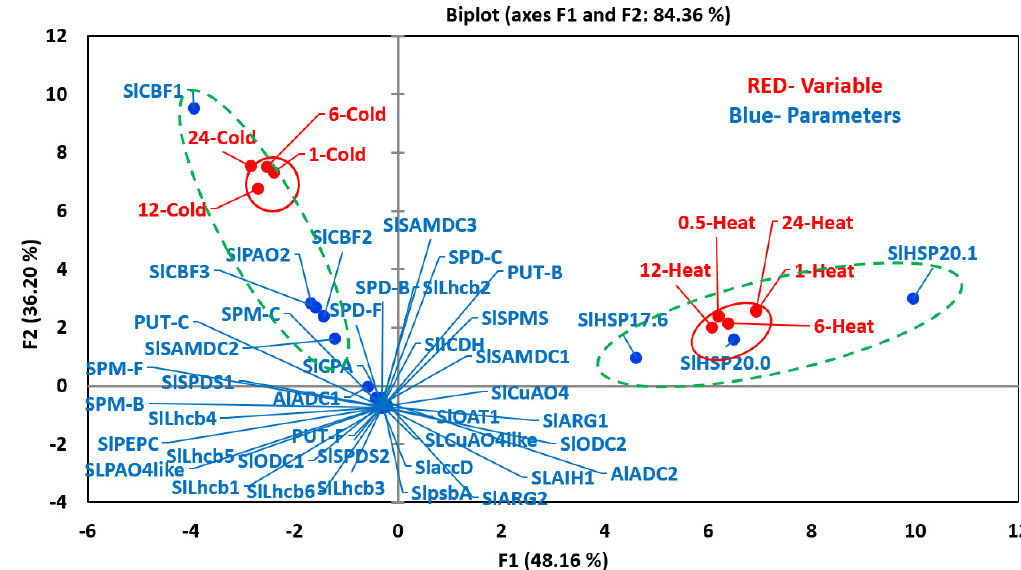
Figure 6. PCA analyses of variables and parameters during heat and cold stresses. The variables included seedlings treated to increasing time period after applying heat (0.5, 1, 6, 12 and 24 h) and cold (1, 6, 12 and 24 h) stresses. The parameters included levels of free (F), conjugated (C) and bound (B) PUT, SPD and SPM (PUT-F, SPD-F, SPM-F, PUT-C, SPD-C, SPM-C, PUT-B, SPD-B and SPM-B), transcript levels of PAs biosynthesis and catabolizing enzymes genes, heat and cold stress maker genes and photosynthetic-machinery-related genes. For PCA analyses, all values for active and variable parameters were normalized as per cent of that at zero time (before the initiation of respective stresses) values. Other details are the same as stated in the Materials and Methods section. Genes’ abbreviations are given in the Supplemental Table S1. PCA analyses was performed using XLSTAT (https://www.xlstat.com).